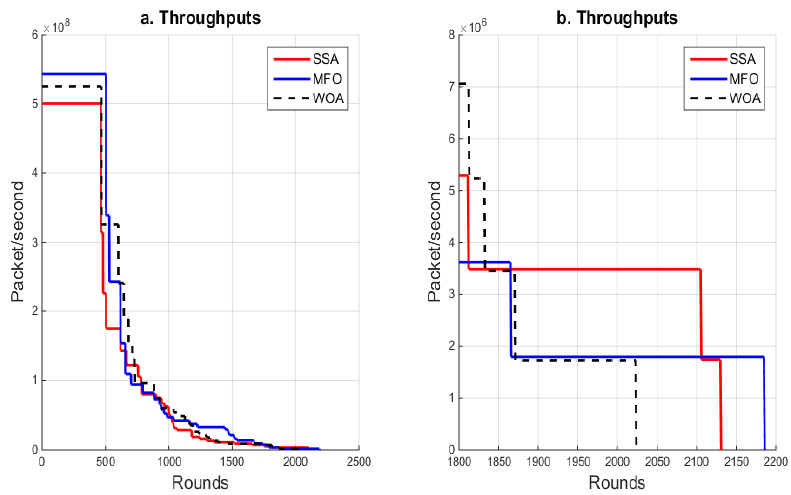
Figure 4. Variation in throughput in MFO, SSA and WOA.